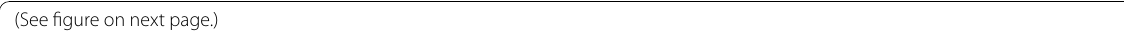
figure on next Fig. 7 A 45-day-old male infant presented with lower back wide deep cutaneous dimple (crater) with small, discolored swelling mildly enlarging with straining shown in A . B , C Axial and Sagittal T2WI showing left para midline subcutaneous cystic lesion (Asterix) at level of S1/S2 vertebrae with a fibrous tract seen extending deeply passing though S2 spinal bifida into spinal canal. D Sagittal T2WI showing termination of conus medullaris at level of mid L4 vertebral body, hypointense tract is seen traceable in CSF space and separately identified till its attachment in dorsal aspect of conus medullaris (white arrow). E Sagittal T1WI showing tiny hyperintense focus on left side of conus medullaris representing intradural lipoma (white arrow). F Axial USG image at level of tip of conus medullaris showing small echogenic well defined fatty lesion representing intradural lipoma (white arrow). G Sagittal USG image at level of upper S1/S2 vertebral level showing subcutaneous cystic lesion with hypoechoic fibrous tract extending deeply into spinal canal. H Sagittal USG image showing level of termination of conus medullaris at mid L4 vertebral body level. I M mode USG image at level of L5 showing absence of oscillation of cauda equina nerve roots denoting tethered cord. Type of spinal dysraphism: Transitional form of LDM with tethered cord and intradural